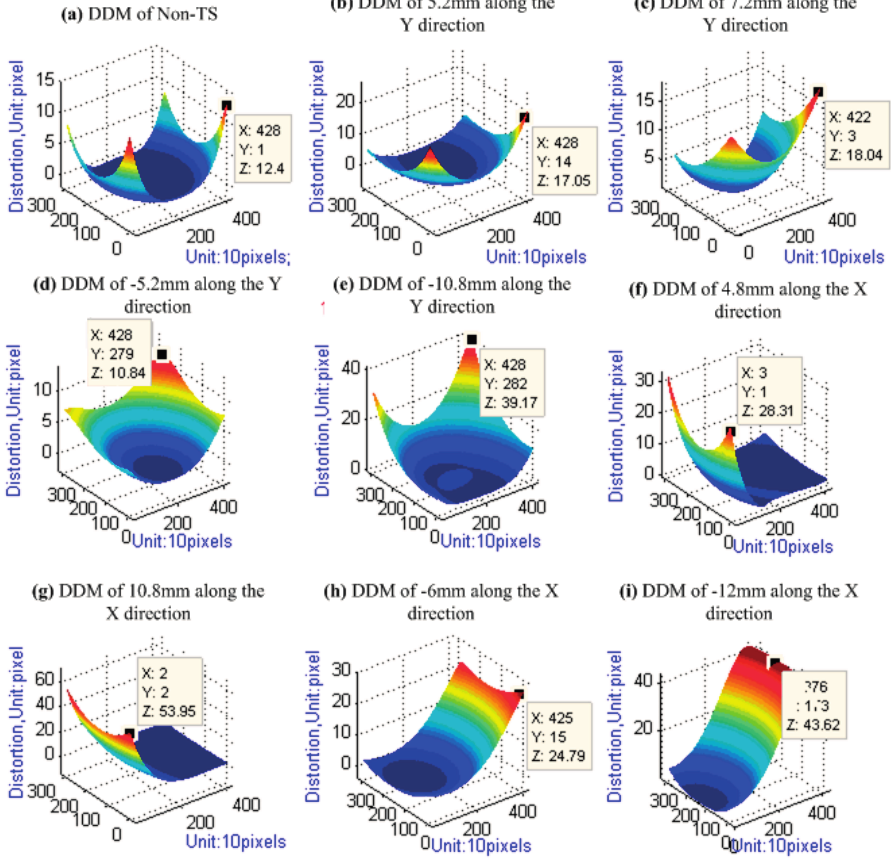
Figure 9. DDM of TSC: ( a ) DDM under the zero tilt-shift condition; ( b – e ) DDM under the tilt-shift along the Y direction; and ( f – i ) DDM under the tilt-shift along the X direction. Pixel size: 5.5 μ